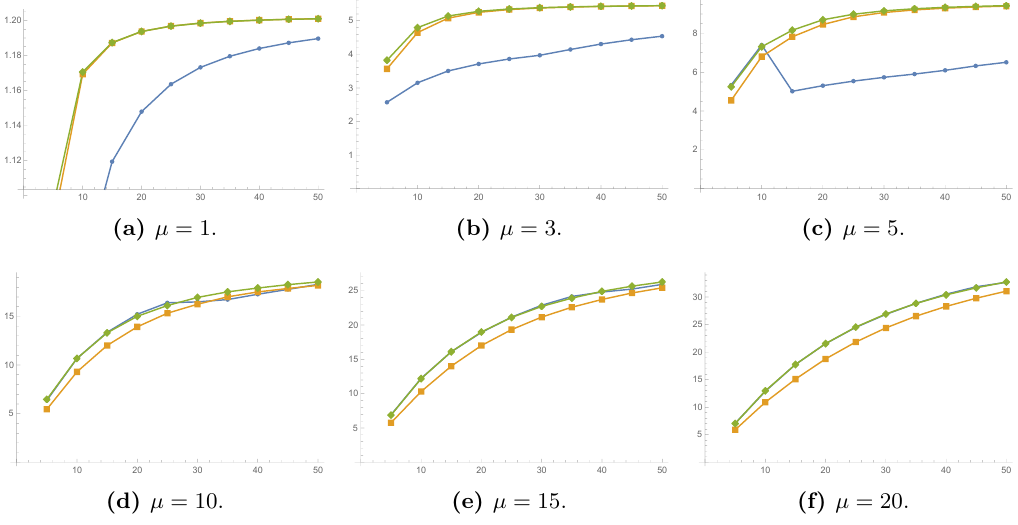
Figure 7 . The location of the peaks. The values of x peak are shown as blue circles (the fuzzy sphere), orange boxes (the usual sphere), and green diamonds (the fuzzy sphere without the non- planar phase factor), for various values of µ . The vertical axis is x L = 5 , · · · , 50 . R is set to